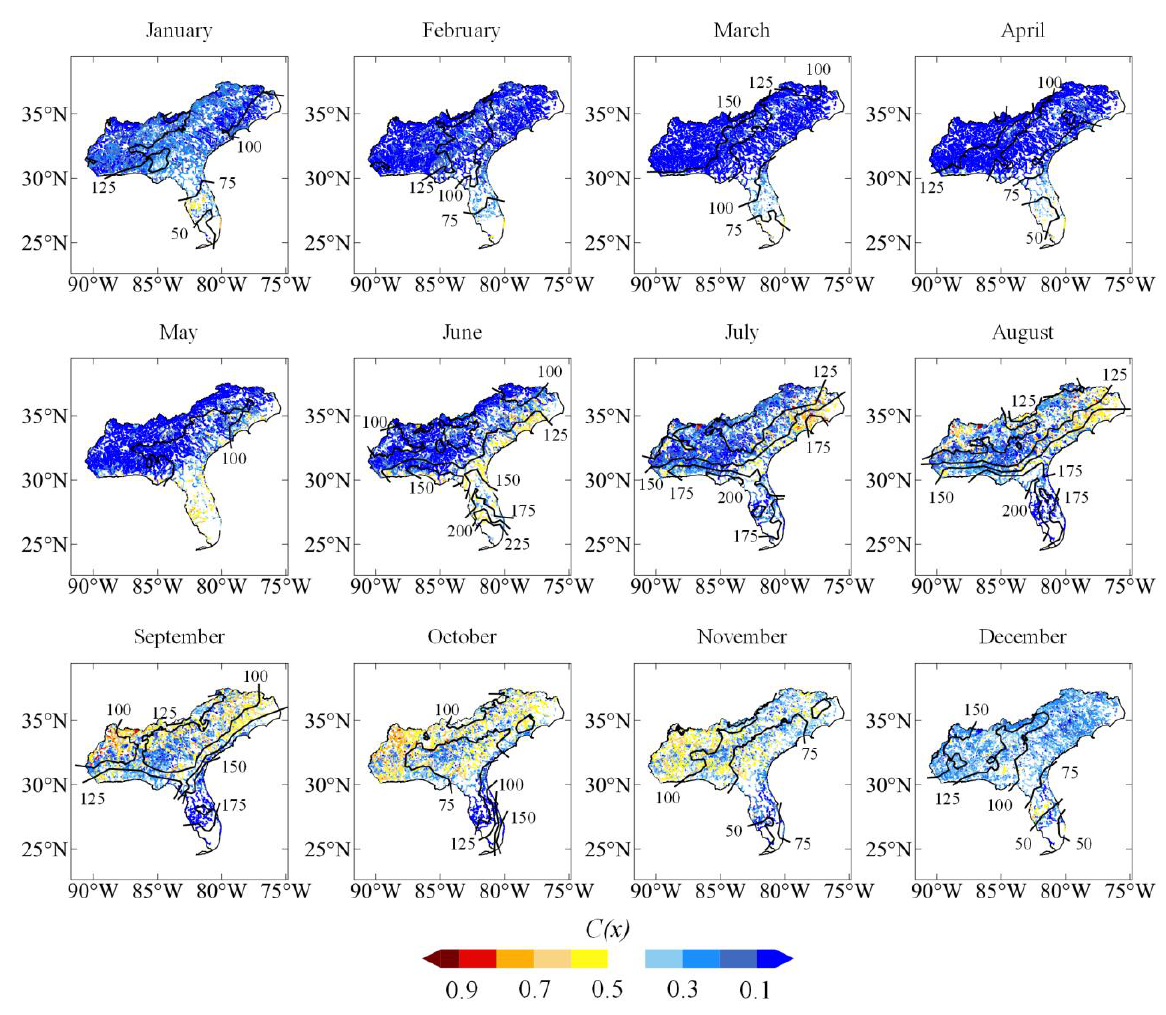
Figure 6. Periodicity ( C(x) ) of streamflow droughts in consecutive months with isohyets of average monthly precipitation (mm).